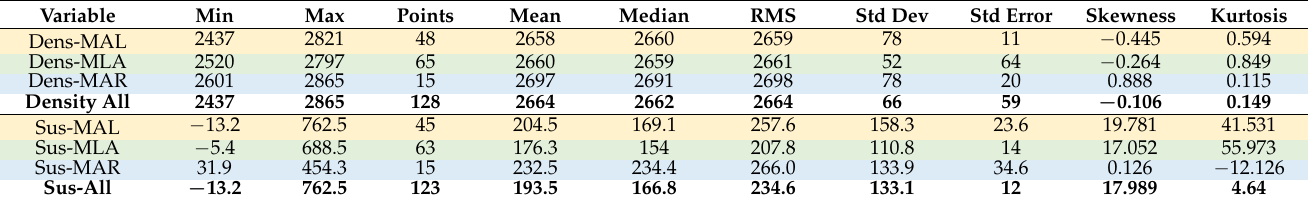
Table 3. Synthesis of statistics of petrophysical data (density and susceptibility) obtained in this paper. Dens(ity) and Magnetic Sus(ceptibility) separately for each pluton, as well as the global means.